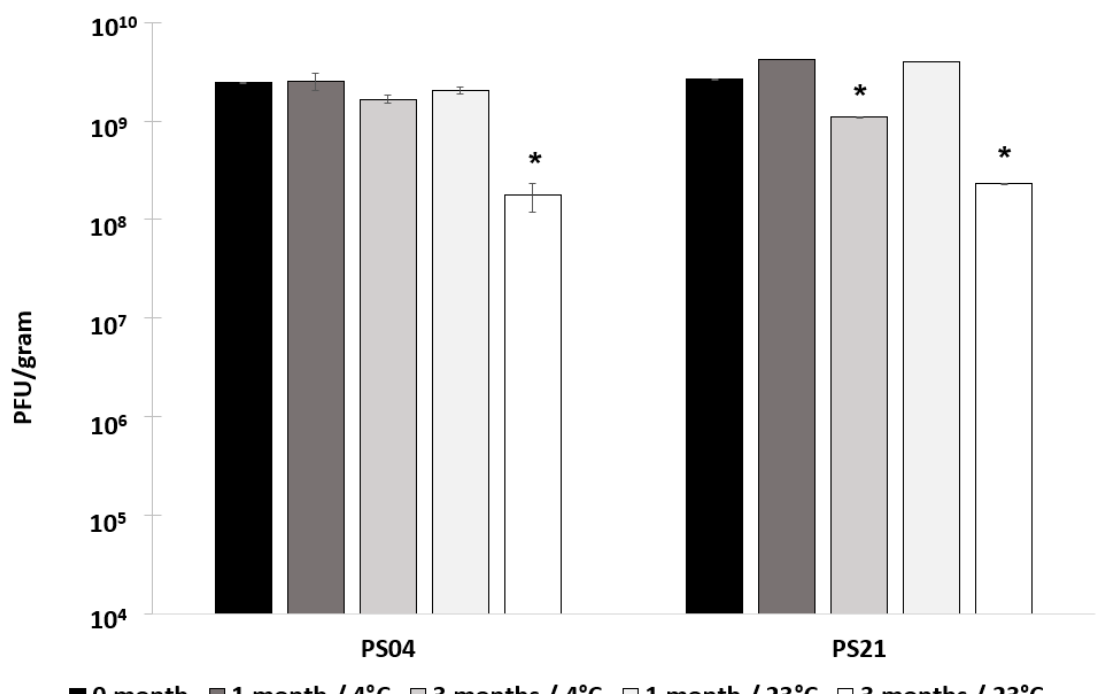
Figure 5. Storage results for formulations PS04 and PS21 used to spray-dry phage Felix O1. Phage titre was measured after one month and three months of storage at 4 °C and 23 °C. * Indicates a significant difference in means in comparison with the mean value immediately after spray-drying (0 months) using a two-sample t -test, ( p < 0.05). Error bars represent one standard deviation; all measurements were done in triplicate ( n = 3).